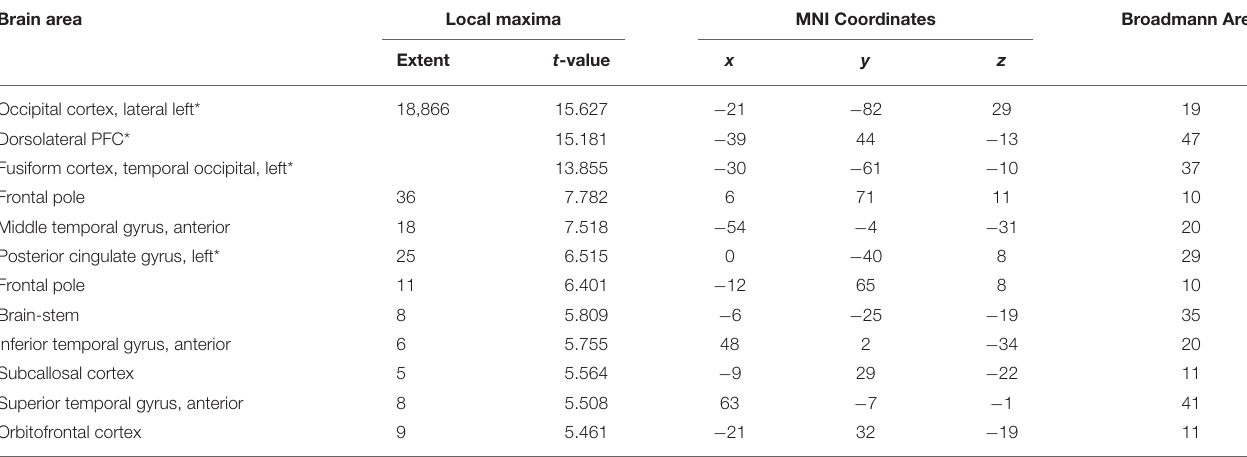
TABLE 3 | Overview of local maxima for brain activity during Anguish versus Tenderness neurofeedback conditions, across the whole brain. Brain